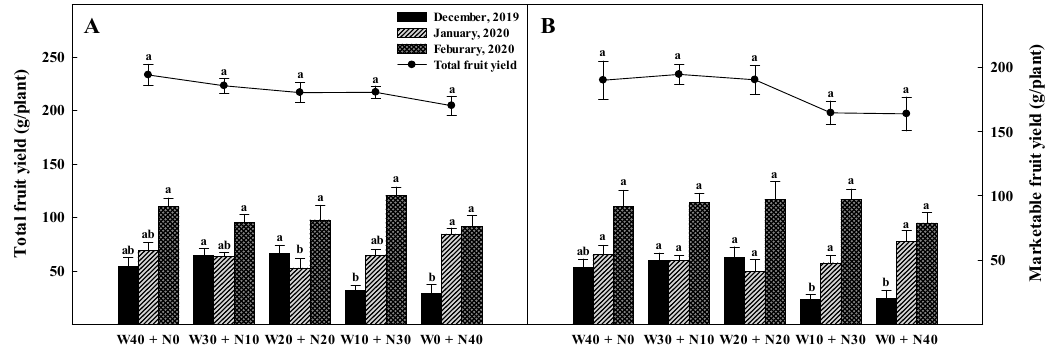
Figure 4. The total fruit yield ( A ) and marketable fruit yield ( B ) of “Maehyang” strawberries a ff ected by the nutrient solution resupply period during the nursery stage. Refer to Figure 1 for details on nutrient solution resupply periods. Vertical bars indicate standard errors of the means ( n = 12). Tukey’s test at p ≤